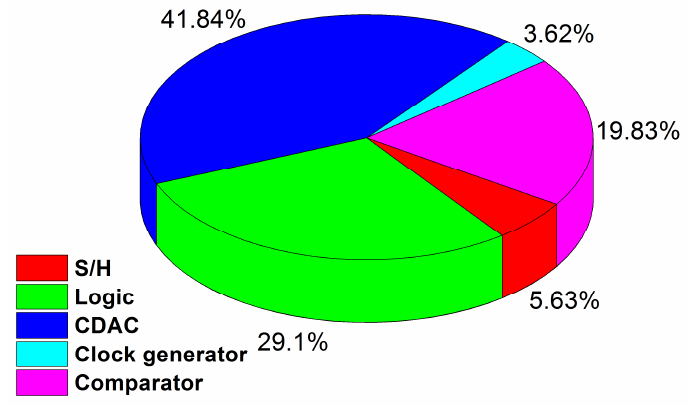
Figure 16. Breakdown of power consumption of ADC.